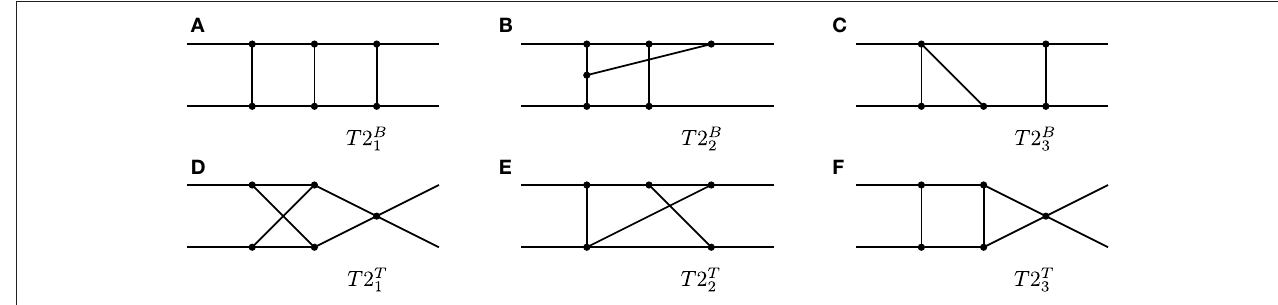
LLHH . Solid dots denote interaction vertices. Crossed lines without a dot at =